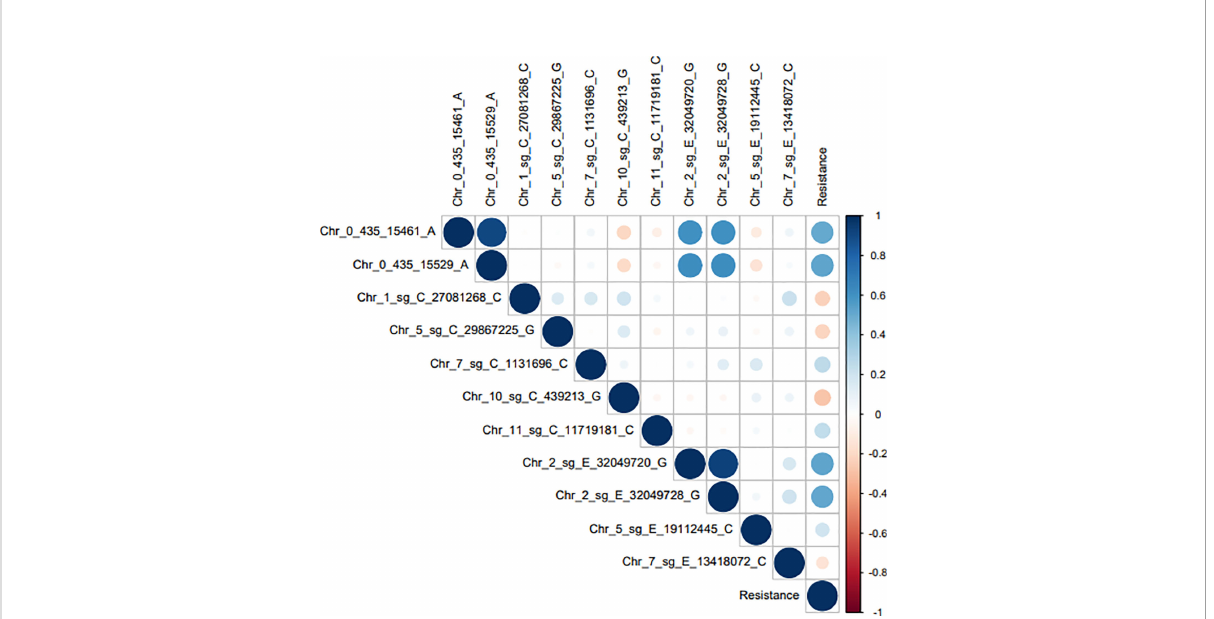
FIGURE 4 Correlation between the 11 QTNs identi fi ed in the GWAS and the resistance to BHB phenotype. The closer to zero, the lower the correlation, positive (blue) or negative (red), which depends on the associated QTN effect.